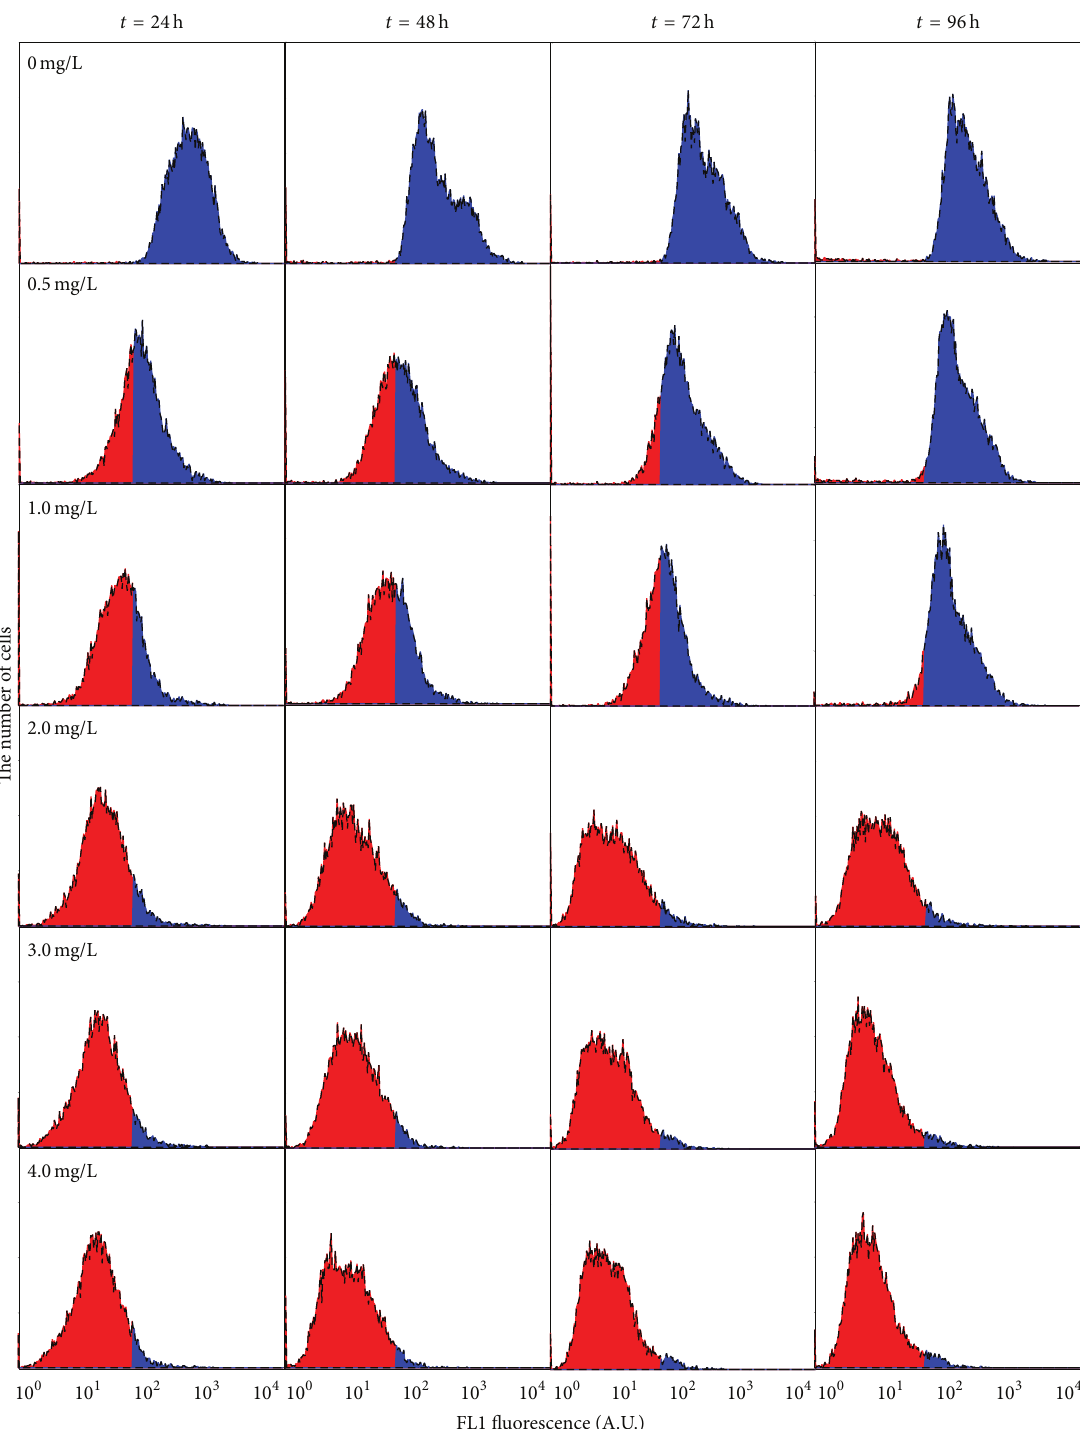
Figure 7: The effects of ethyl cinnamate on the FDA staining fluorescence of Chlorella vulgaris